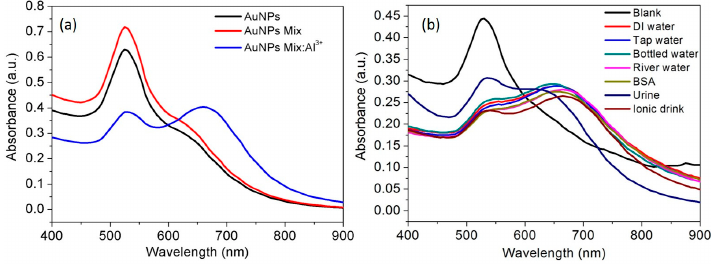
Figure 7. ( a ) The spectral response of AuNPs towards the Al 3+ in presence of mixture of multiple kinds of metal ions at room temperature; ( b ) The spectral response of AuNPs towards the Al 3+ in real samples at room temperature.